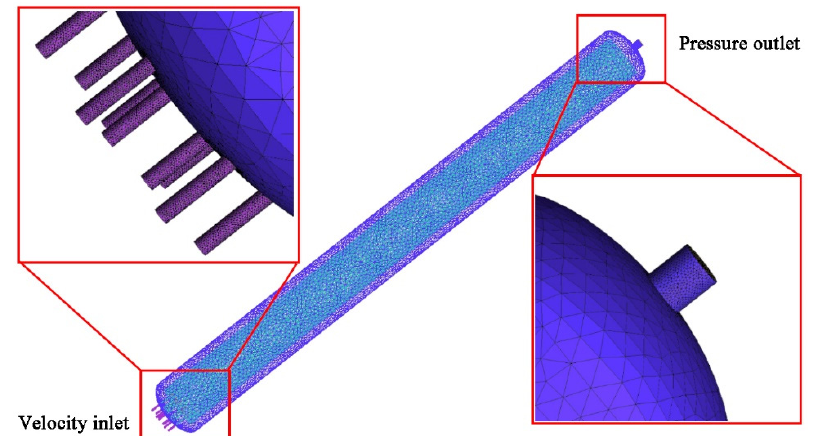
Figure 2. Schematic diagram of model grid.